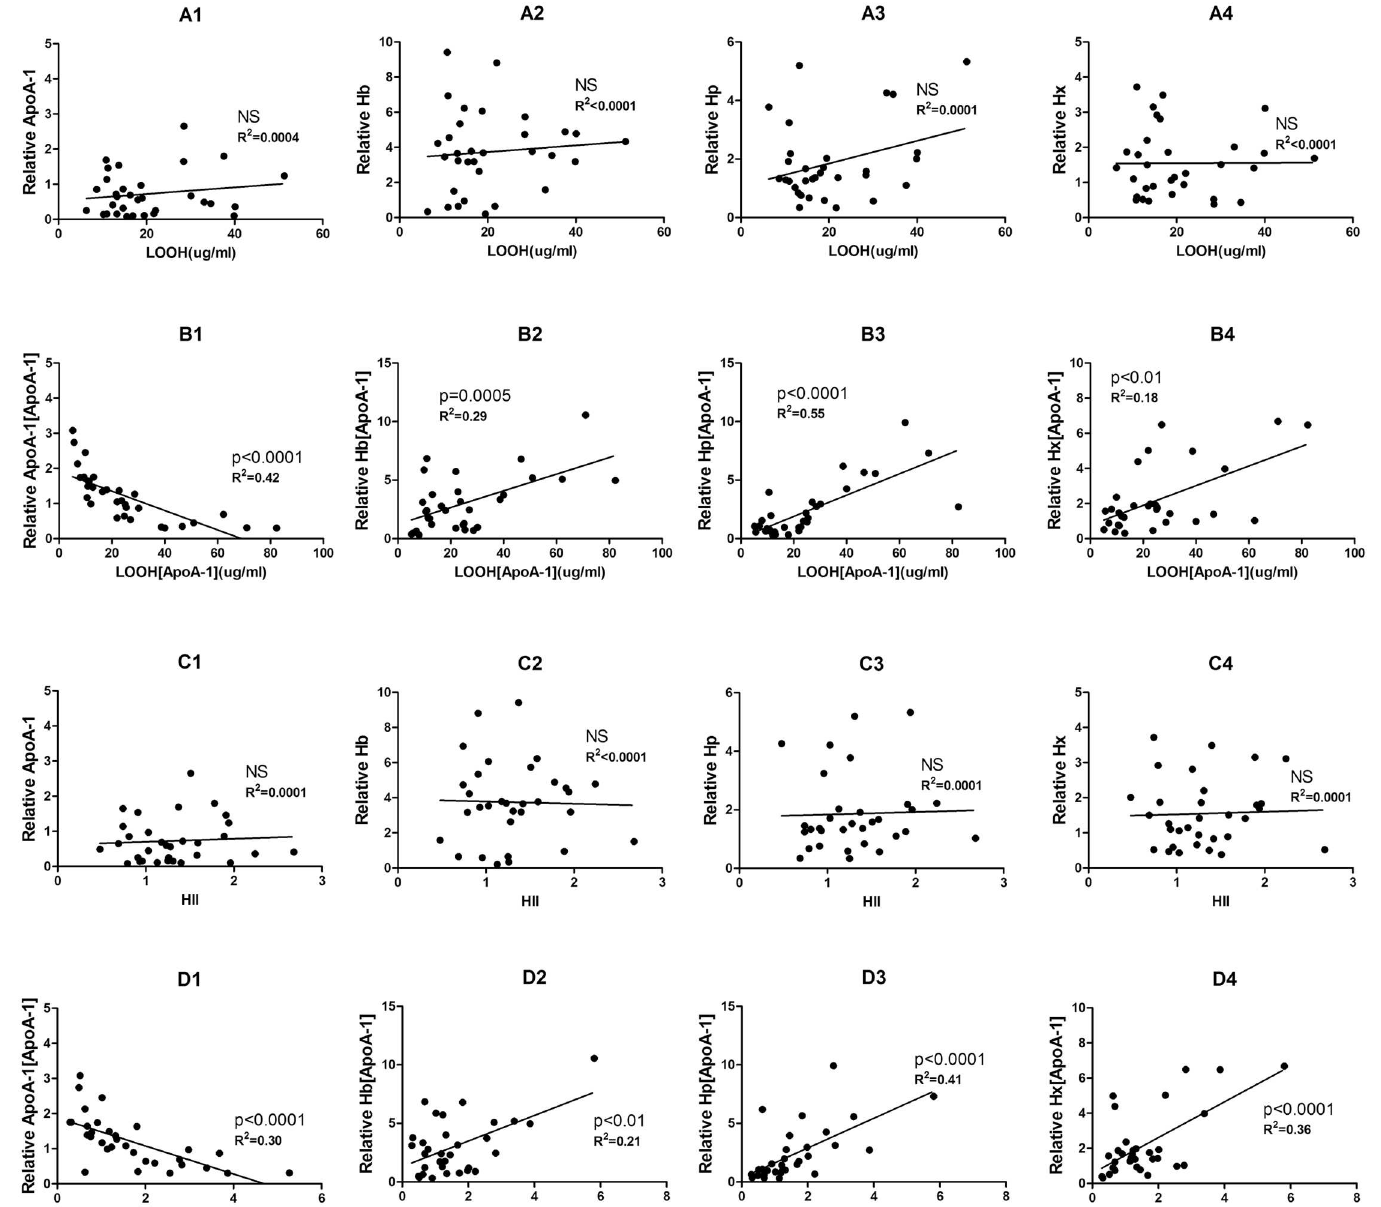
Fig 1. Plasma hemoglobin (Hb), haptoglobin (Hp) and hemopexin (Hx) in HDL are linearly correlated with lipid hydroperoxide (LOOH) and HDL inflammatory index (HII). “[ApoA-1]” means “in ApoA-1 particles”. Results in SCD patients (n = 32): ApoA-1, Hb, Hp and Hx levels in plasma (A1–-A4, respectively) or ApoA-1 particles, Hb, Hp, and Hx associated with ApoA-1 (B1–B4, respectively) vs. LOOH content in ApoA-1 particles. ApoA-1, Hb, Hp and Hx levels in plasma (C1–C4) or those associated with ApoA-1 (D1–D4) vs. HII measured by monocyte chemotaxis activity (MCA). Linear regression was performed individually and p values and R 2 values are shown in the figures. (NS = not